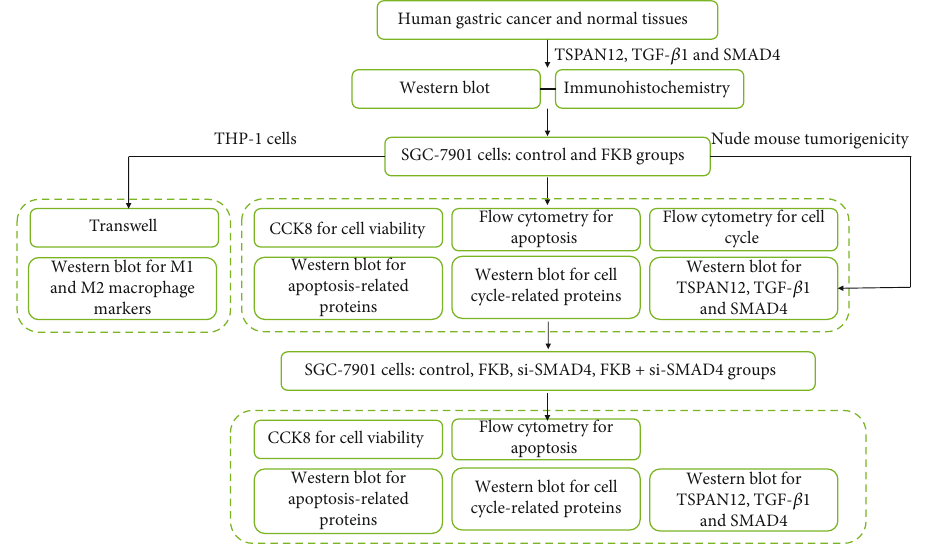
Figure 9: The fl owchart of the study